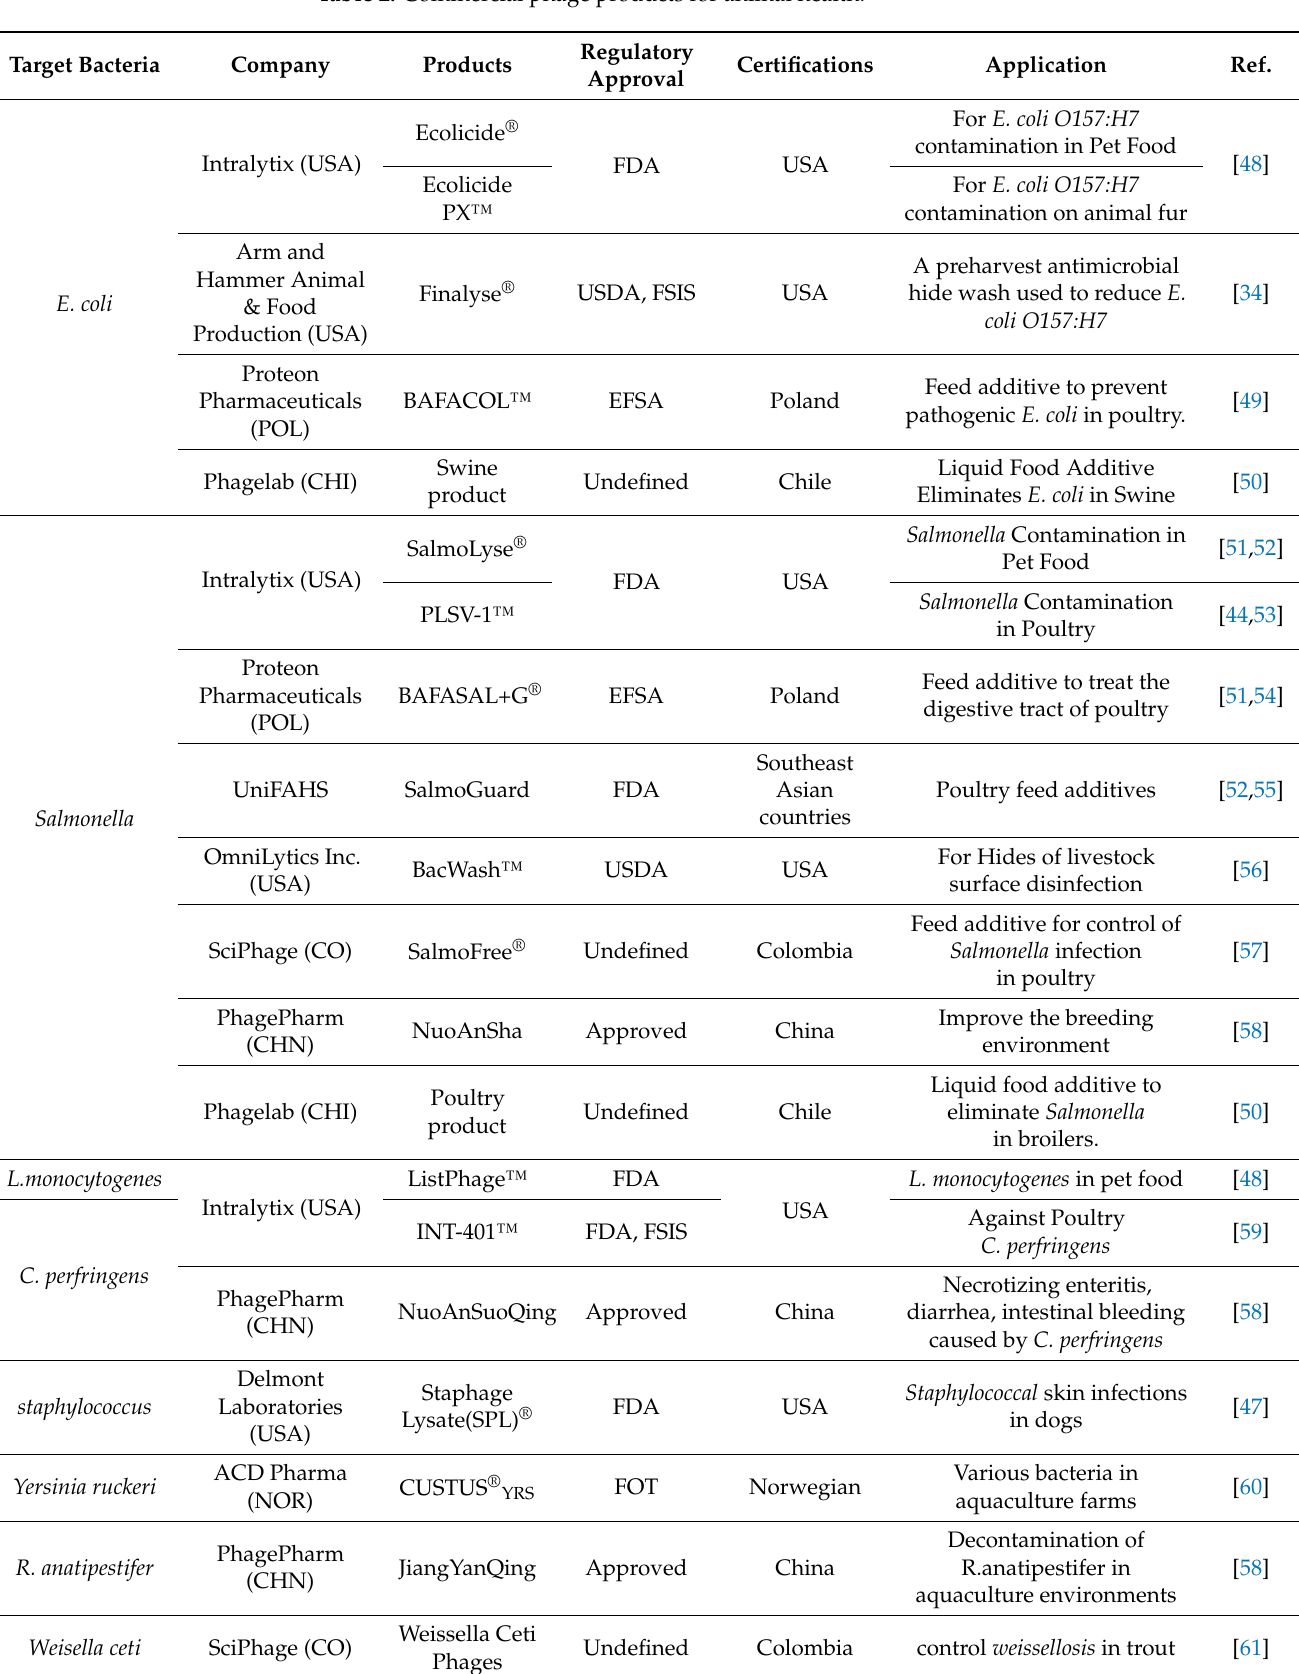
Table 2. Commercial phage products for animal